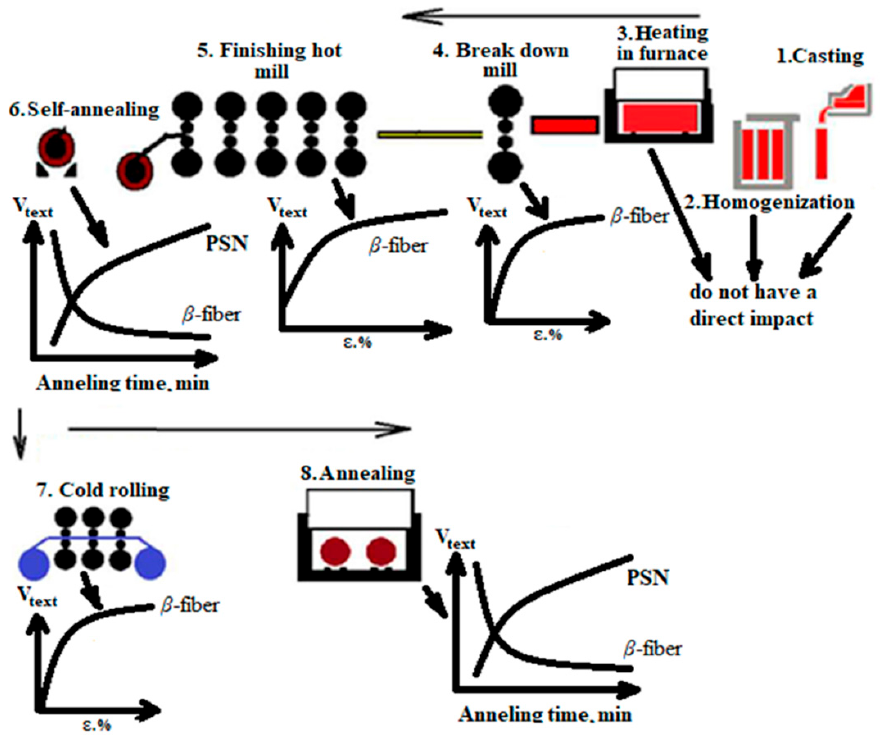
Figure 1. The main stages of thermomechanical treatment for the AlMg 6 Mn 0.7 (1565 ch) alloy, including the features of changing the volume fraction of the main textural components.